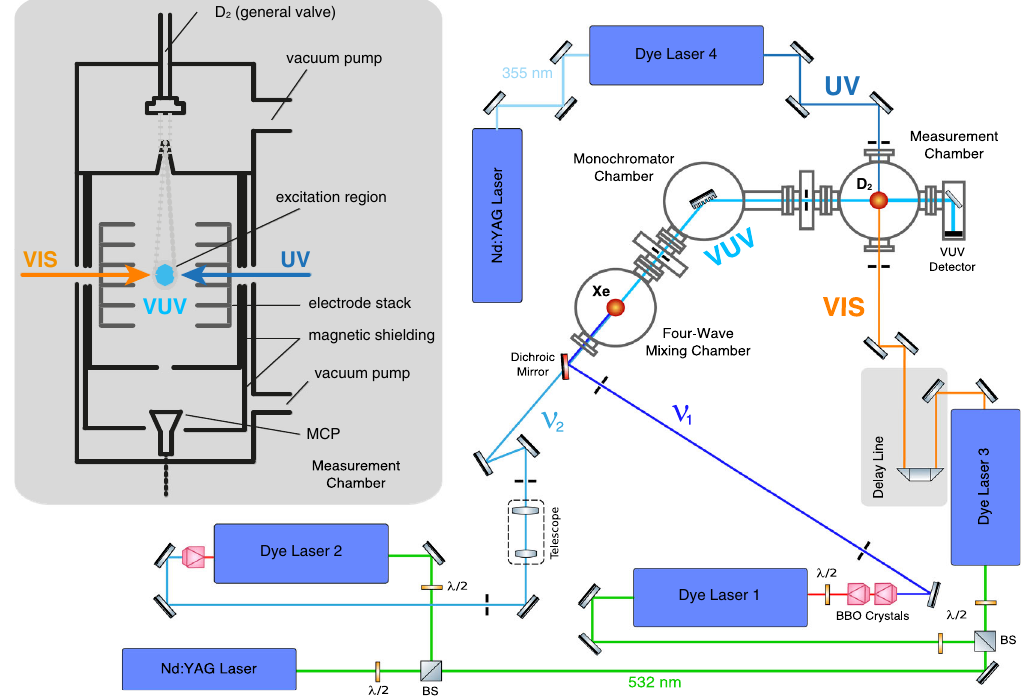
FIG. 1. Schematic representation of the experimental setup with the laser system, the vacuum chambers and the photoexcitation